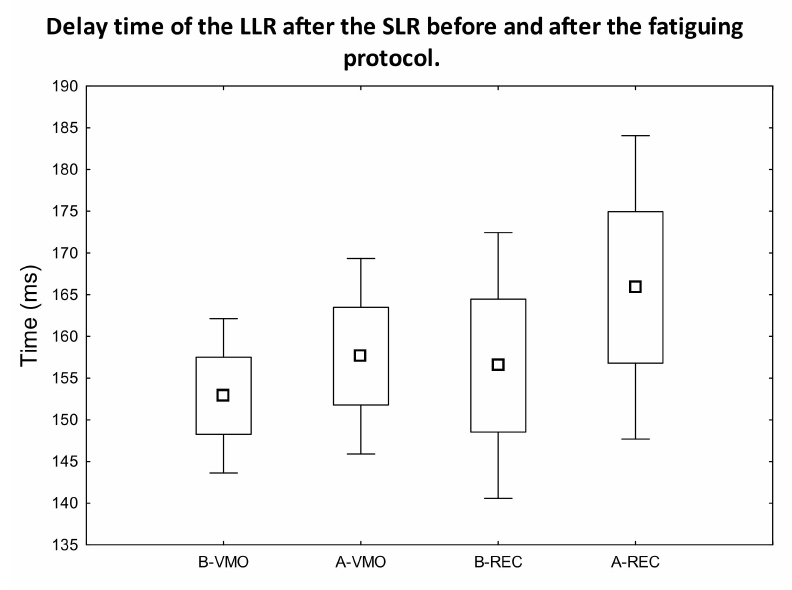
Figure 4. Delay time of the LLR after the SLR before and after the fatiguing protocol. Box: mean ± SE; whiskers: mean ± 2SE. No significant difference could be observed between B-VMO and A-VMO and between B-REC and A-REC, respectively ( p >